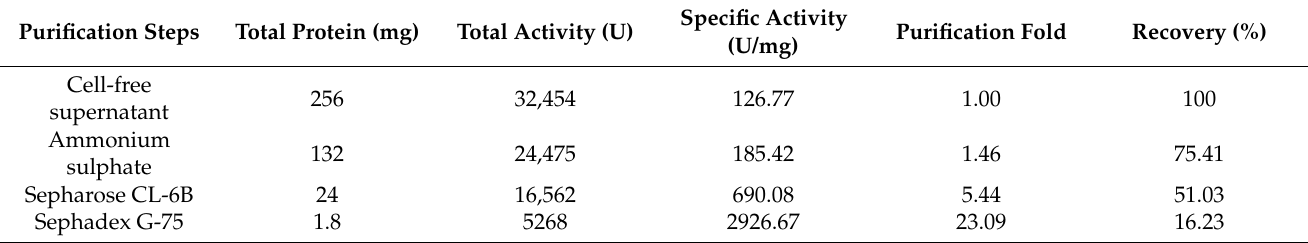
Table 1. Purification steps of protease SH21 from Bacillus siamensis